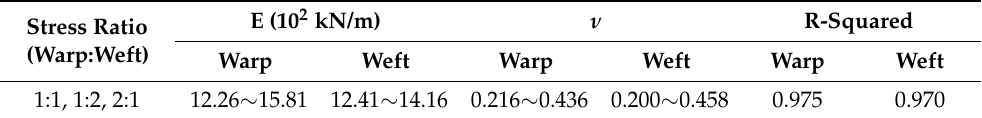
Table 4. Results of the optimizations.